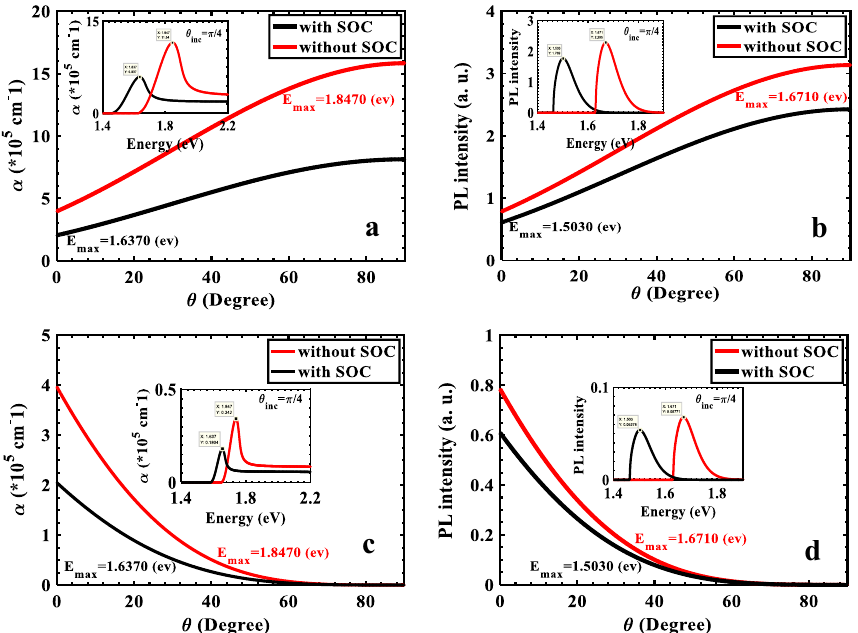
Figure 6. The peak value of ( a , c ) the absorption coefficient and ( b , d ) the photoluminescence intensity with (black line) and without (red line) SOC versus the incident angle of the radiation light at K - and K ′ -valleys with up and down spins. The polarization of incident light at K - and K ′ -valleys are ( a , b ) e RHS , respectively. Insets depict for certain value of incident angle as θ inc